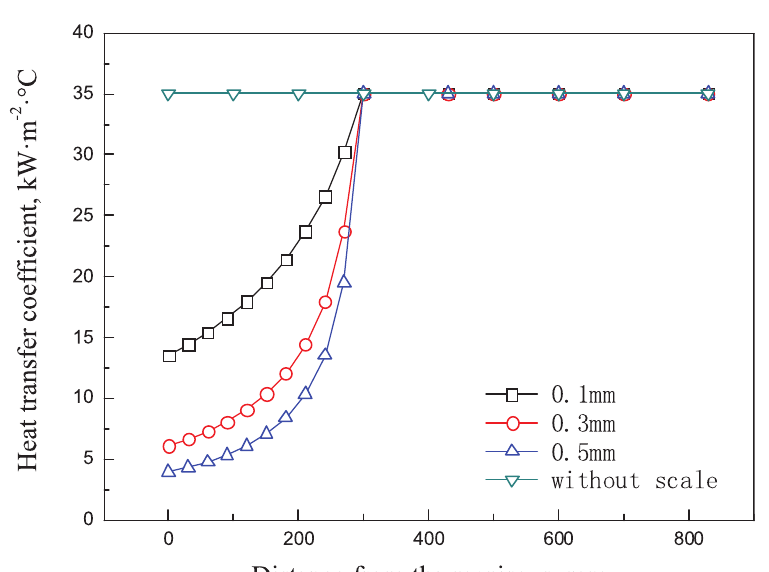
Figure 3: Heat transfer coefficient between copper surface and cooling water for different scale